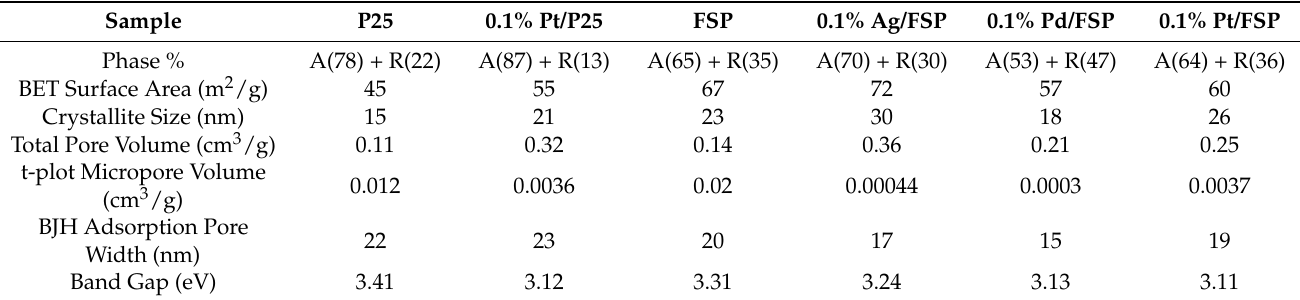
Table 1. Results of the catalysts characterisation.